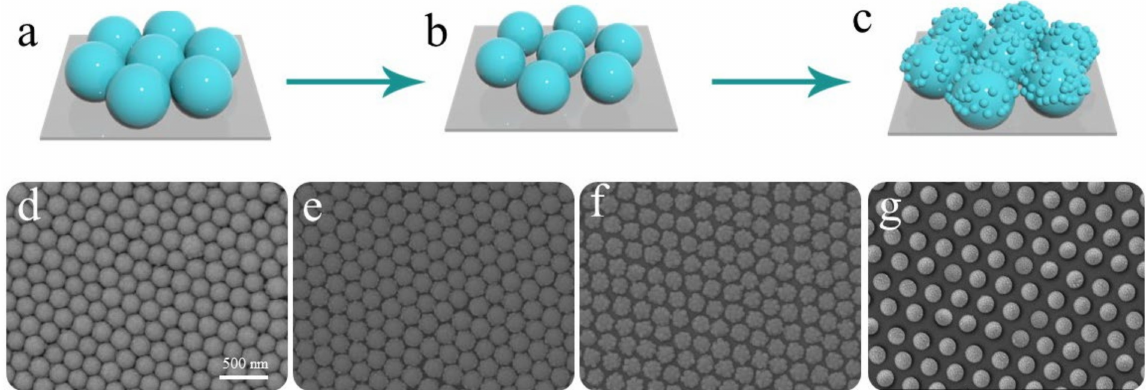
Figure 1. ( a – c ) Schematic diagram of the preparation phases of sunflower-like structure; ( d – g ) SEM image of the samples with different etching time (3, 4, 5, and 6 min, respectively) after 20 min of